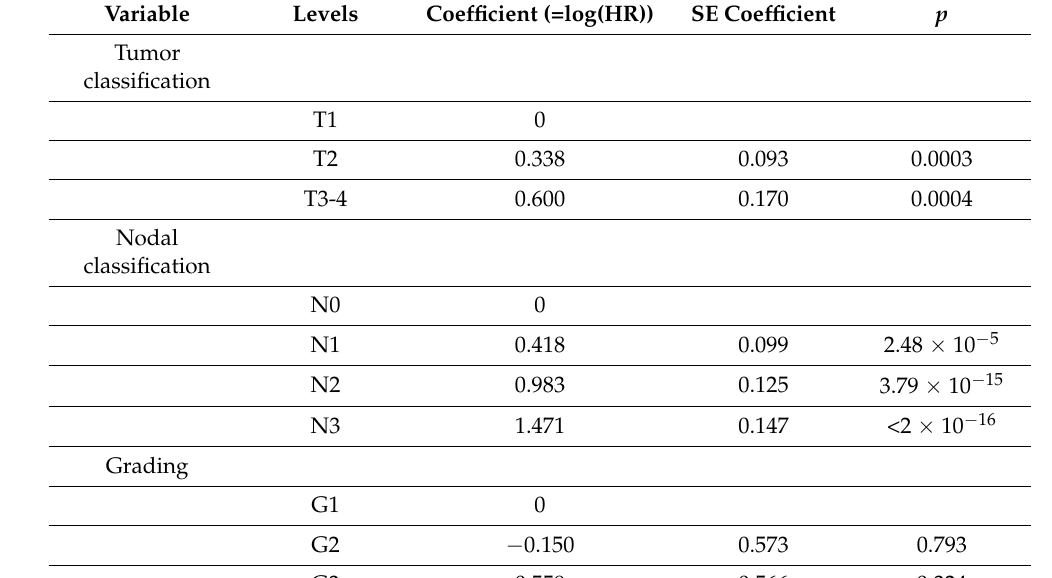
Table 7. Multivariate analysis of breast-cancer-specific survival from METABRIC dataset.